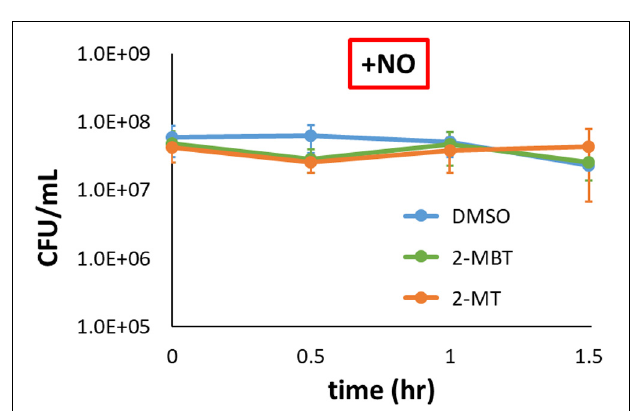
FIGURE 6 | Culturability of imp4213 in the presence of 2-MBT or 2-MT during NO stress. Bacterial survival under NO in the presence of 50 µ M of 2-MBT, 50 µ M of 2-MT, or 25 µ L of DMSO was quantified by measuring CFU/mL every 30 min. NO was provided by DPTA in these assays. The solid circles are the mean CFU/mL measurements from 3 independent replicates, and the error bars represent the standard errors of the means.